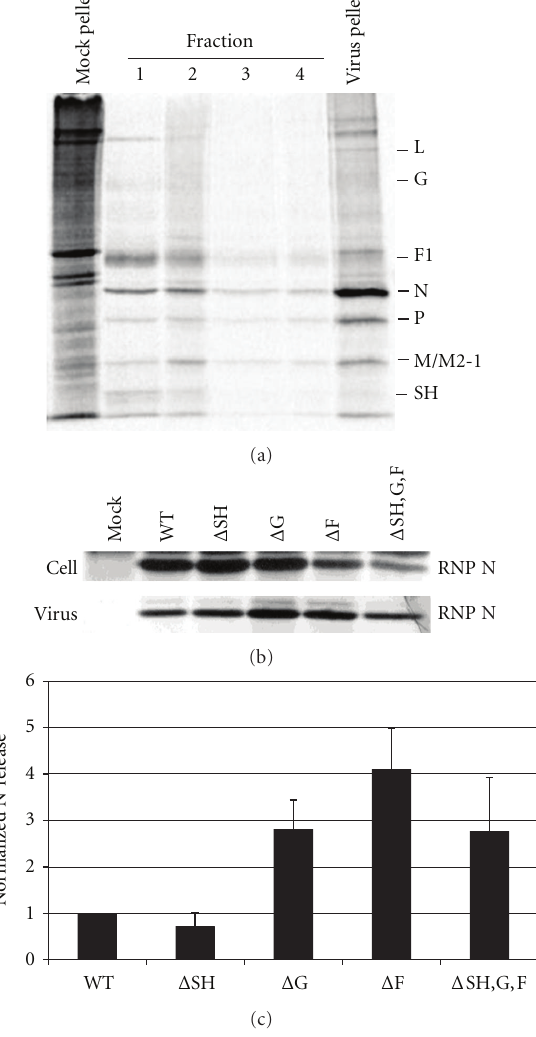
Figure 5: E ff ect of glycoprotein deletions on the release of virions from infected A549 cells. A549 cells were infected with WT or glycoprotein deleted virus and particles released into the supernatant were quantified as a percent of total virus produced. The N protein in isolated RNPs was used to quantitate the virus in cell lysates and in virions. (a) Separation of RNPs containing the viral genome and associated proteins from soluble proteins in infected cell lysates. Infected cell lysates were ultracentrifuged through a 40% glycerol cushion. Fractions were taken from the top of the tube (fraction 1) to the bottom of the tube (fraction 4) in 0.5 mL volumes. The pellet was resuspended in 0.1 mL lysis bu ff er. Viral proteins in each fraction and the pellet were immunoprecipitated and analyzed on a 12% SDS polyacrylamide gel. A representative gel is shown. HRSV proteins are indicated on the right of the gel. (b) Ribonucleoprotein (RNP) associated N protein in infected cell lysates was harvested as described above and in Section 4, and viral proteins were analyzed by immunoprecipitation and electrophoresis on 12% SDS gels. Released virions were recovered from supernatant fluids by centrifugation and viral proteins were analyzed by immunoprecipitation and electrophoresis on 12% SDS gels. A representative gel is shown. (c) Bar graph depicts the percent of N protein quantified in released virus from total RNP-associated N protein quantified in infected cell lysate and in released virus. The N protein was quantitated by phosphoimage analysis. Error bars represent standard deviation from at least three